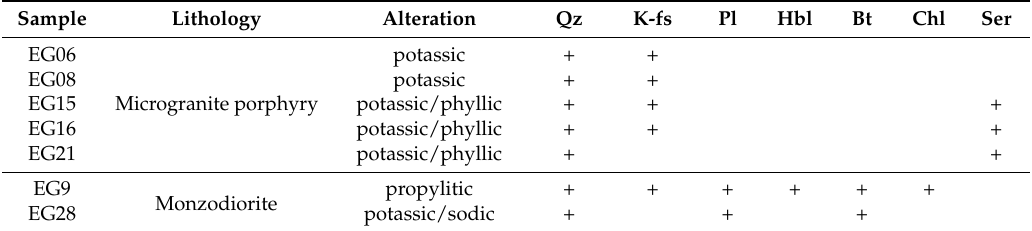
Table 2. Mineralogical content of selected hydrothermally-altered samples defined by X-ray diffraction (XRD) analyses.